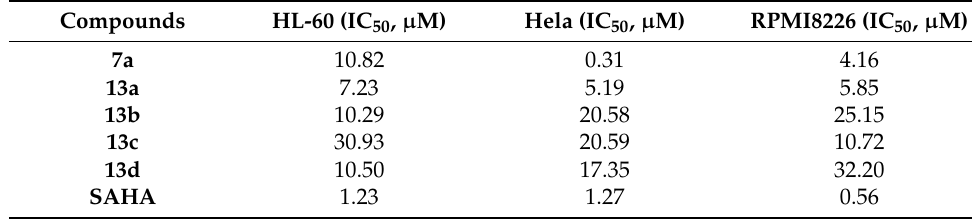
Table 2. Inhibitory activity of 5 representative compounds on three cancer cell lines.